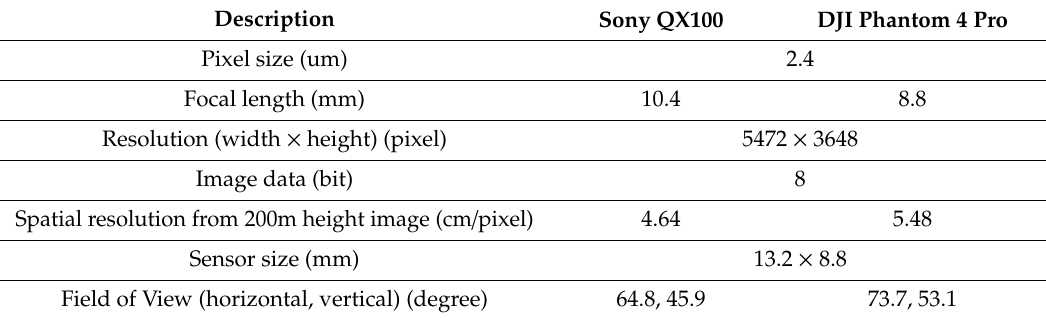
Figure 2. High-resolution orthomosaic images: ( a ) 2019 image, ( b ) 2019 image with histogram matching process, and ( c ) 2017 image. Table 1. UAV imaging sensor